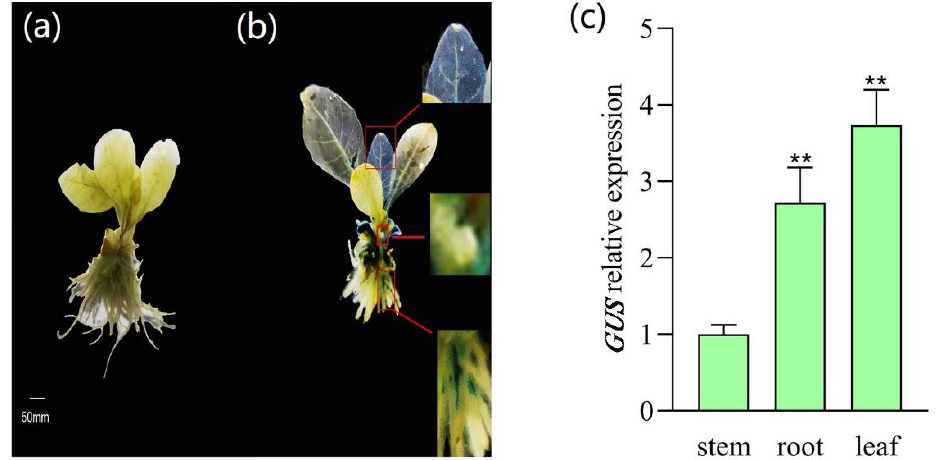
Figure 4. Tissue-specific analysis of the SRPP promoter in tobacco. ( a ): Wild-type tobacco served as control. ( b ): The GUS histochemical staining of the full-length TkSRPP promoter transgenic tobacco. The upper right, middle right, and lower right images show local magnification of leaves, stems and roots, respectively. ( c ): Relative expression of GUS in different tissues was evaluated by RT-PCR. The bars represent standard errors, and the asterisks indicate statistical significance determined by the student’s t -test (** p ≤ 0.01).